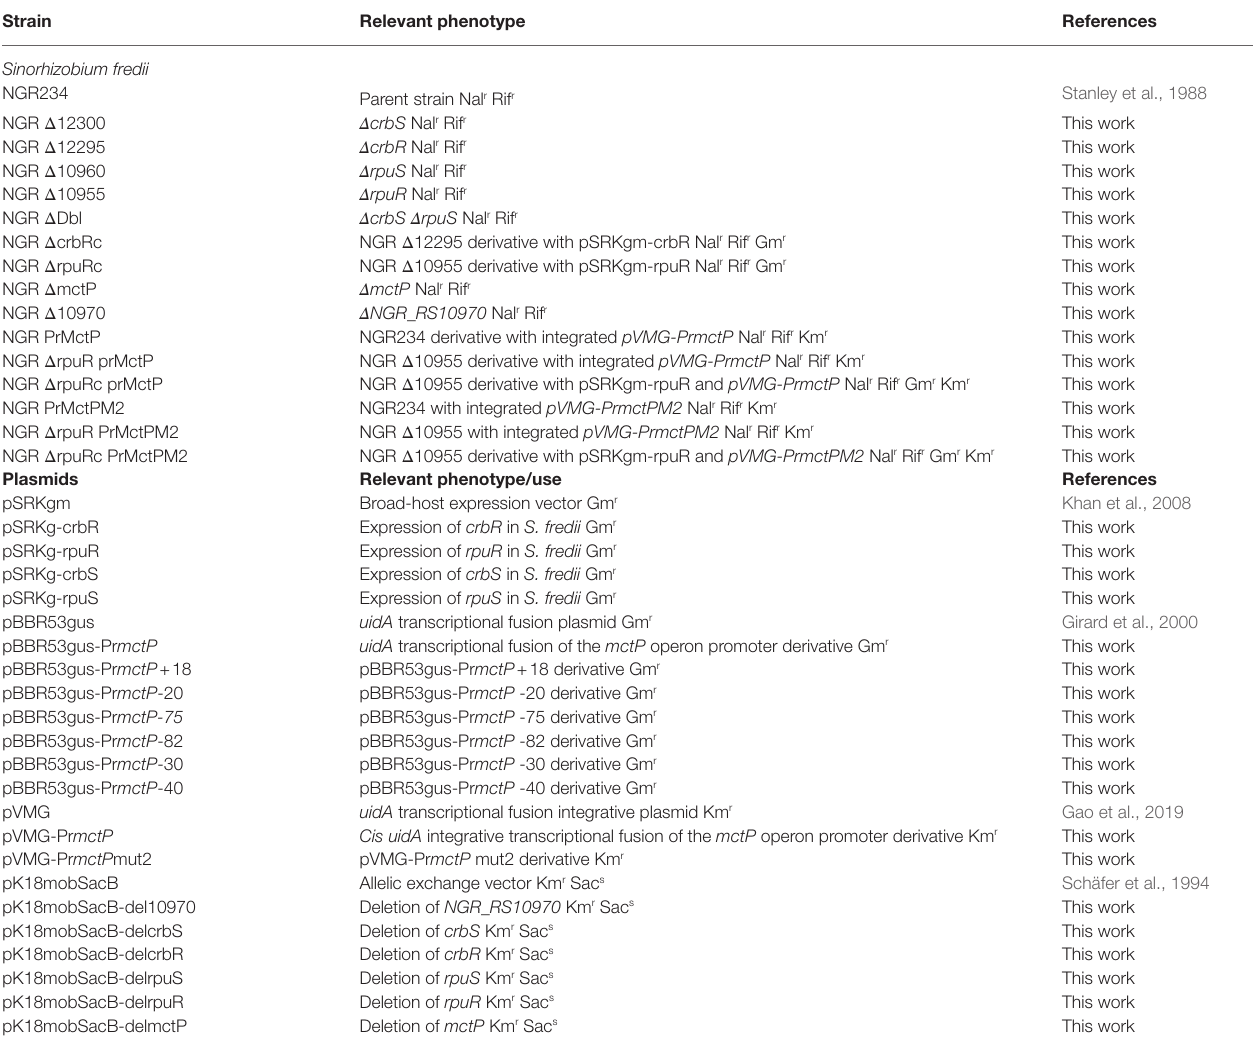
TABLE 1 | Strains and plasmids used in this